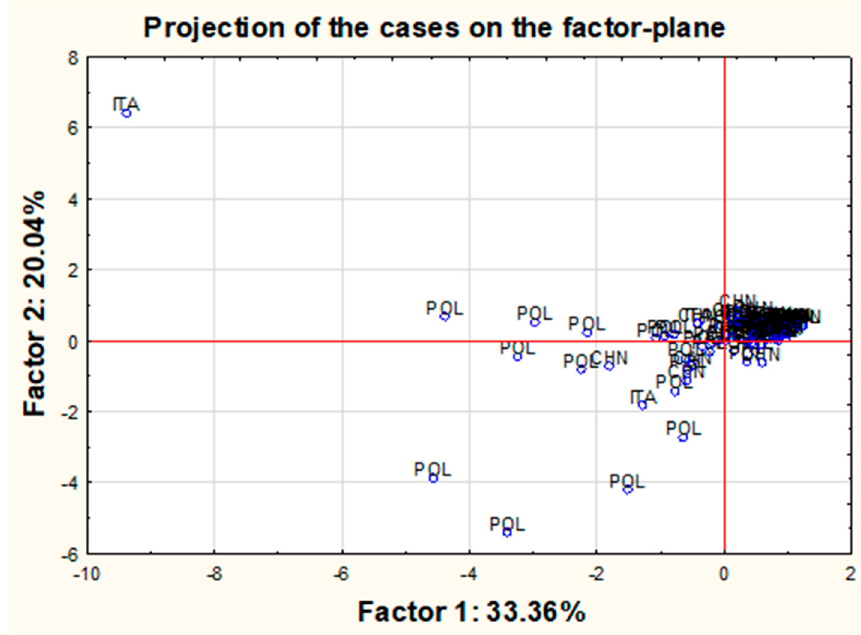
Figure 9. Projection of objects for the first two components for all studied eye shadow samples after the scale change in relation to the country of origin.